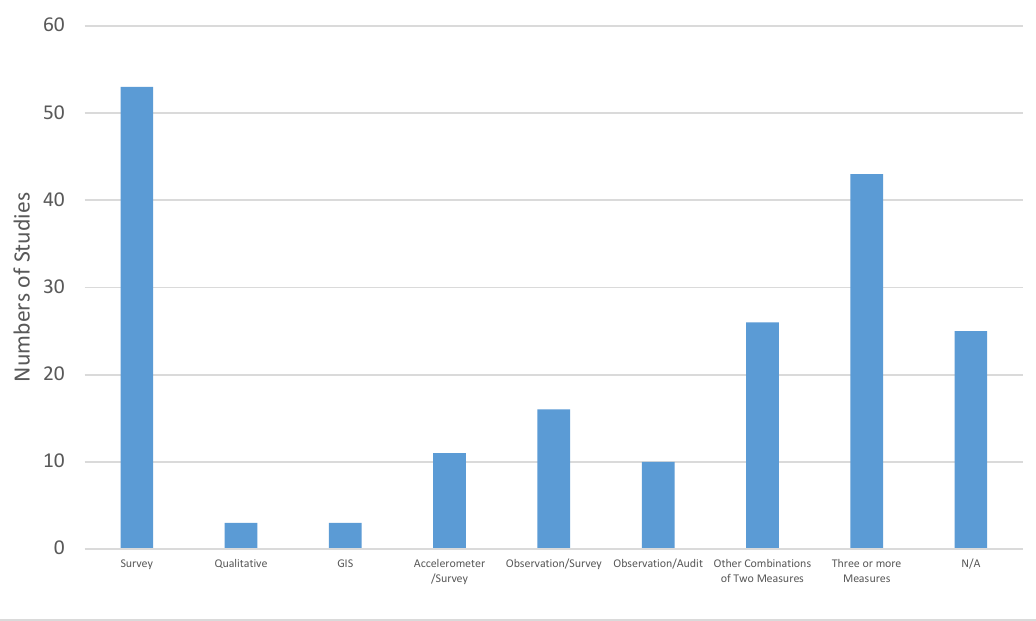
Figure 5. Measurement approaches used in the studies considered in this review were carried